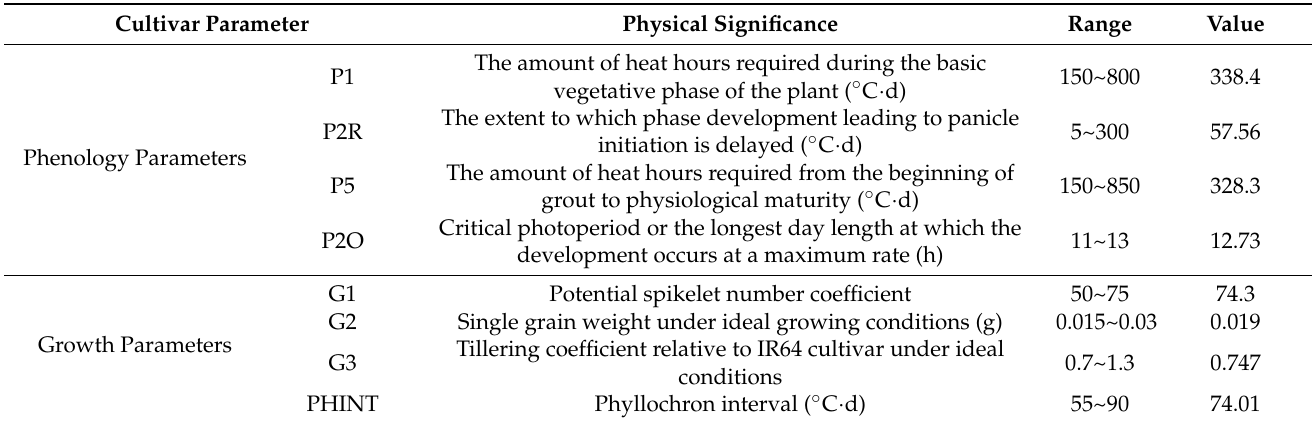
Table 2. The calibration parameters for “Suijing 18”.